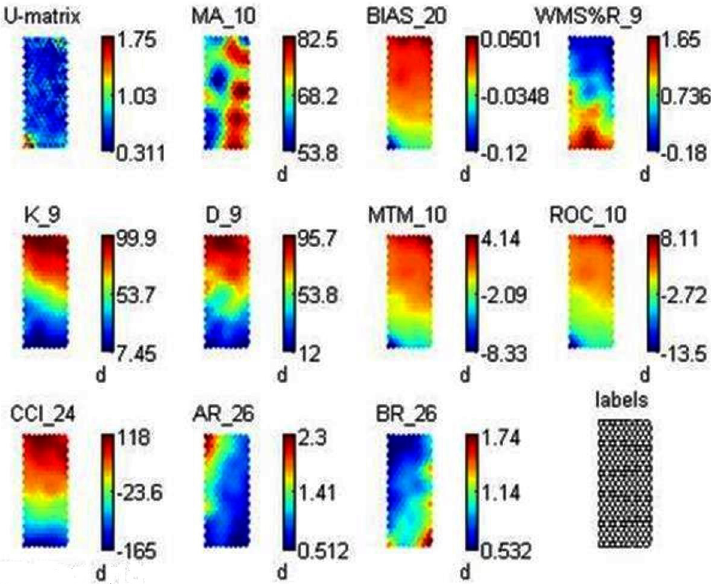
Figure 4. U-Matrix and planes of the SOM network. The results called “labels” on the bottom right are reproduced for clearness in Figure